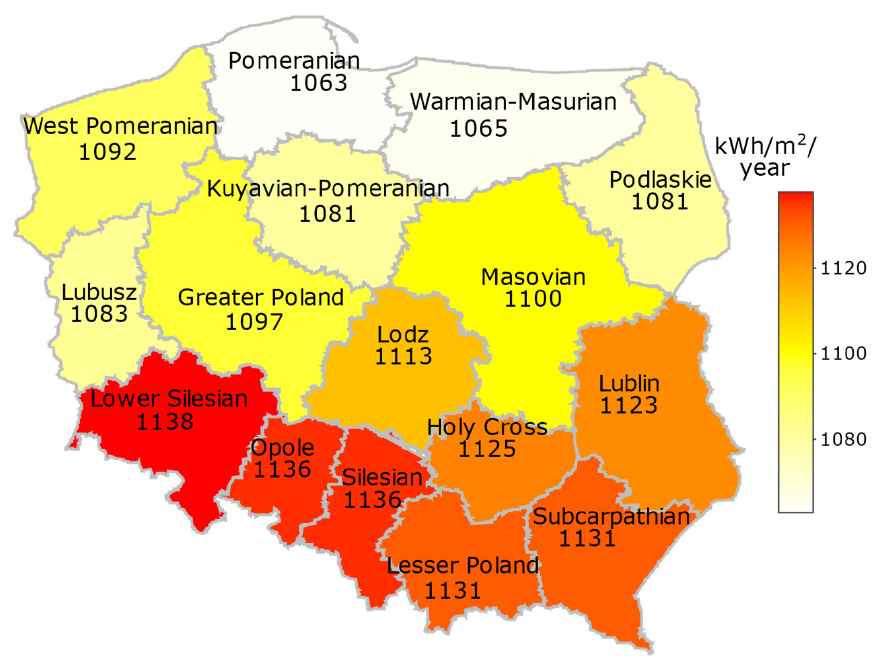
Figure 2. Poland’s sun exposure (insolation) conditions averaged for individual provinces. Source: own study based on [29] .